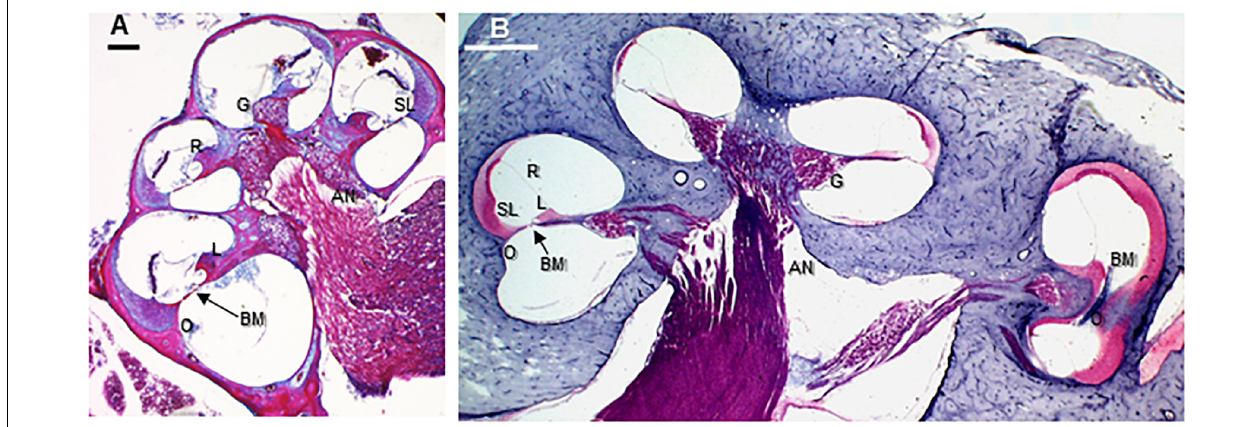
FIGURE 3 | Paramodiolar sections showing basal, middle, and apical turns in the big brown bat ( Eptesicus fuscus ) and harbor porpoise ( Phocoena phocoena ). AN, auditory nerve; BM, basilar membrane; G, ganglion cells; L, spiral limbus; O, outer spiral lamina; R, Reissner’s membrane; SL, spiral ligament. Scale bars = 0.1 mm. (A) Big brown bat ( E. fuscus ) trichrome stained paramodiolar cross-section. (B) Harbor porpoise ( P. phocoena ) H&E stained midmodiolar section. The location of this section approximates the position of the microCT cross-section in Figure 2D . The basilar membrane is shown in an ascending longitudinal position in the hook region. The cochlea is inverted from the in vivo position to match conventional cochlear section image orientations. Images copyright© 2020 AS and DK, all rights